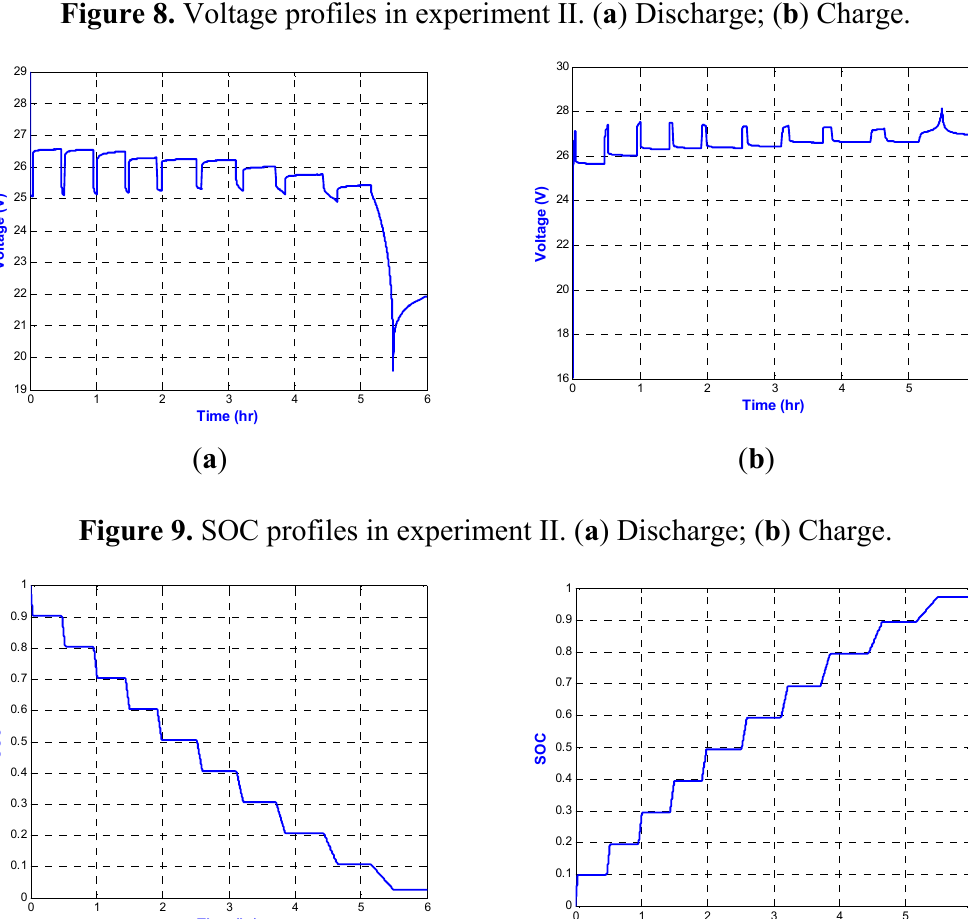
Figure 8. Voltage profiles in experiment II. ( a ) Discharge; ( b ) Charge.